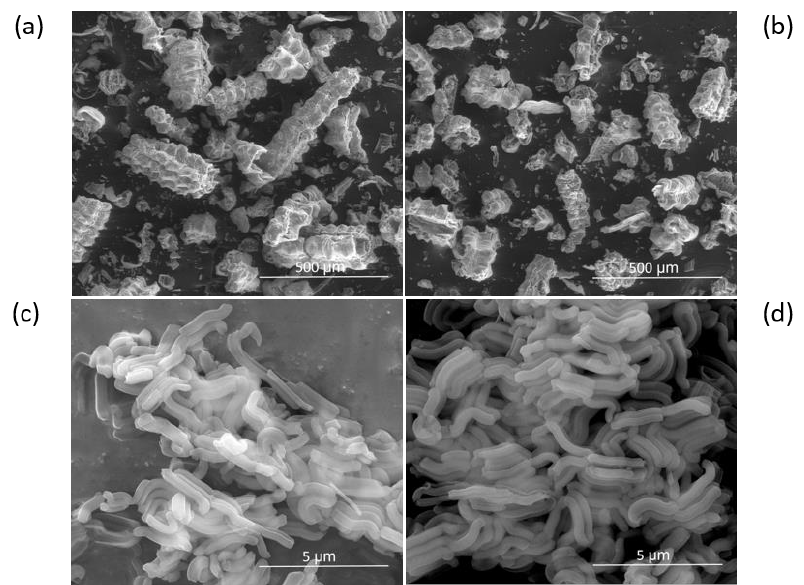
Figure 5. SEM images of RHA ( a ), TRHA ( b ), SBA-15 ( c ), and Ros4PyMe@SBA ( d ).